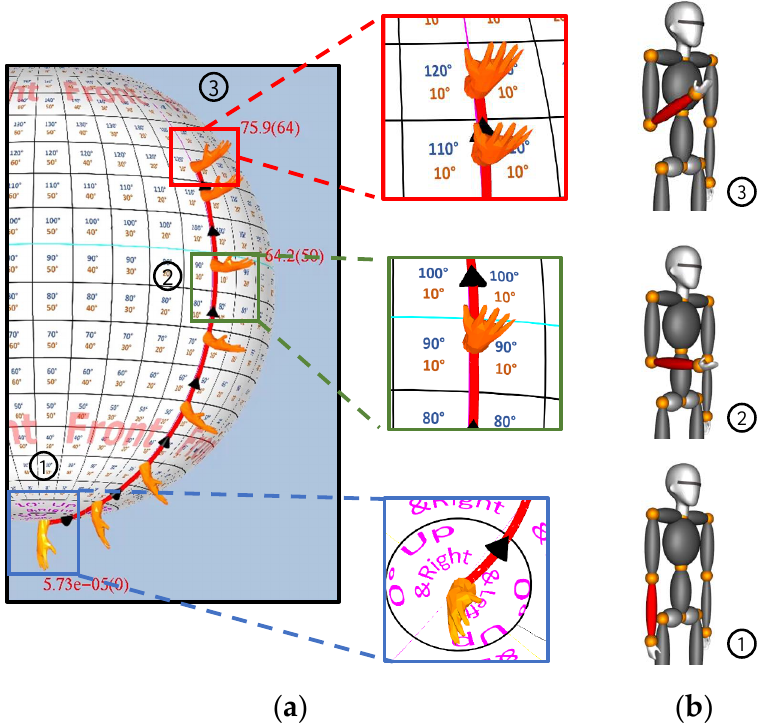
Figure 6. An example of a twist-swing combined motion. ( a ) A front swing of the right lower arm to the body (120 ◦ ), with a positive twist (gradient red shade 0 ◦ –64.2 ◦ –75.9 ◦ ). ( b ) The avatar view is as seen from the person’s right